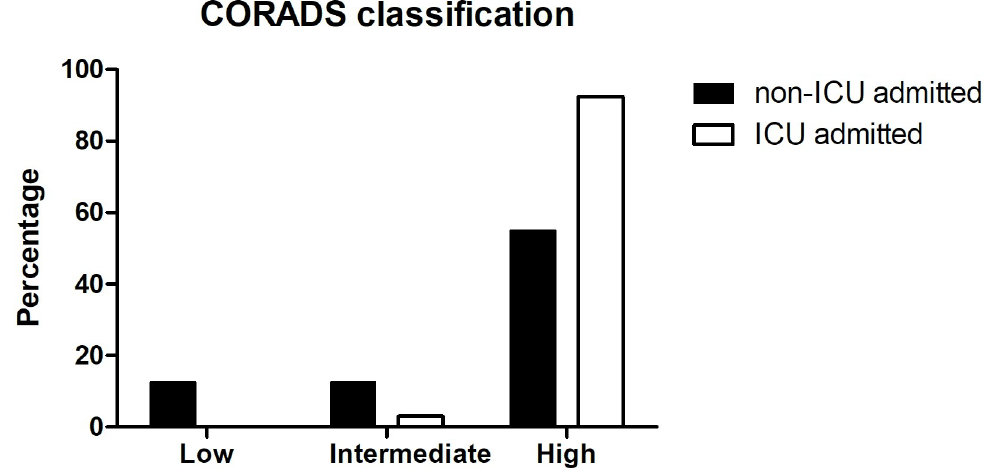
Fig 4. Bar graph showing the CO-RADS distribution across the COVID-19 positive patients demarcated into non- ICU and ICU